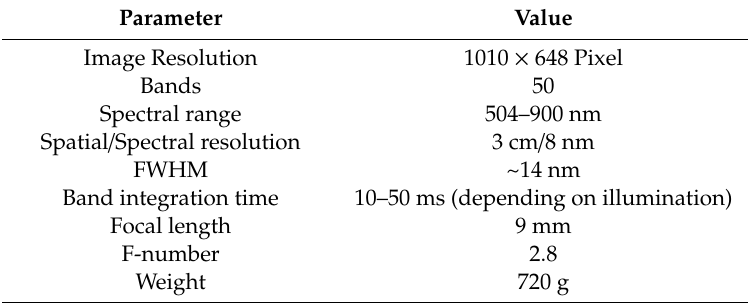
Table 2. Technical data and settings of the Rikola camera during flight